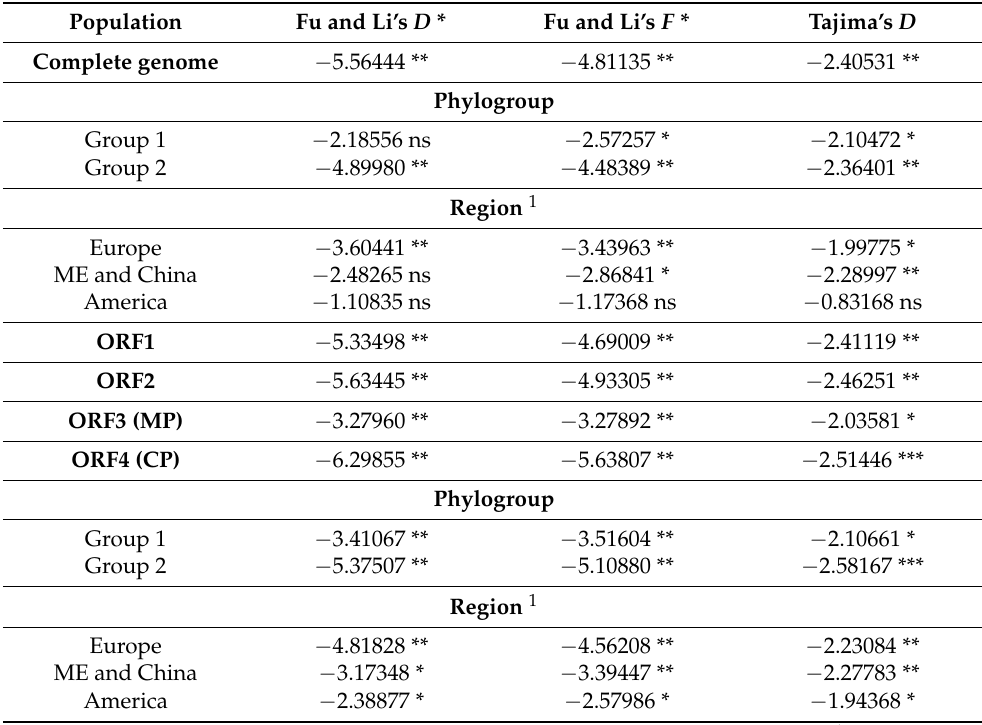
Table 2. Results from demography test statistics between sequences of the complete genome, ORF1, ORF2, ORF3 (MP), and ORF4 (CP) of ToBRFV populations. Population Fu and Li’s D * Fu and Li’s F * Tajima’s D Complete genome − 5.56444 ** − 4.81135 ** − 2.40531 ** Phylogroup Group 1 − 2.18556